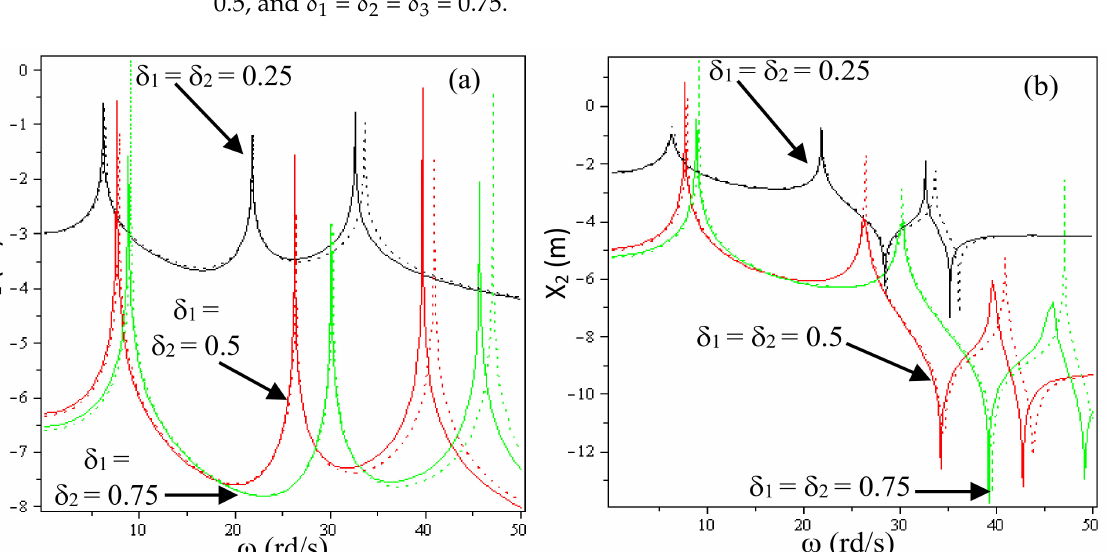
Figure 8a–c present, respectively, the evolution of the displacement x 1 , x 2 , and x 3 as a function of the circular natural frequency ω and that for δ 1 = δ 2 = δ 3 = 0.25, δ 1 = δ 2 = δ 3 = 0.5, and δ 1 = δ 2 = δ 3 = 0.75.